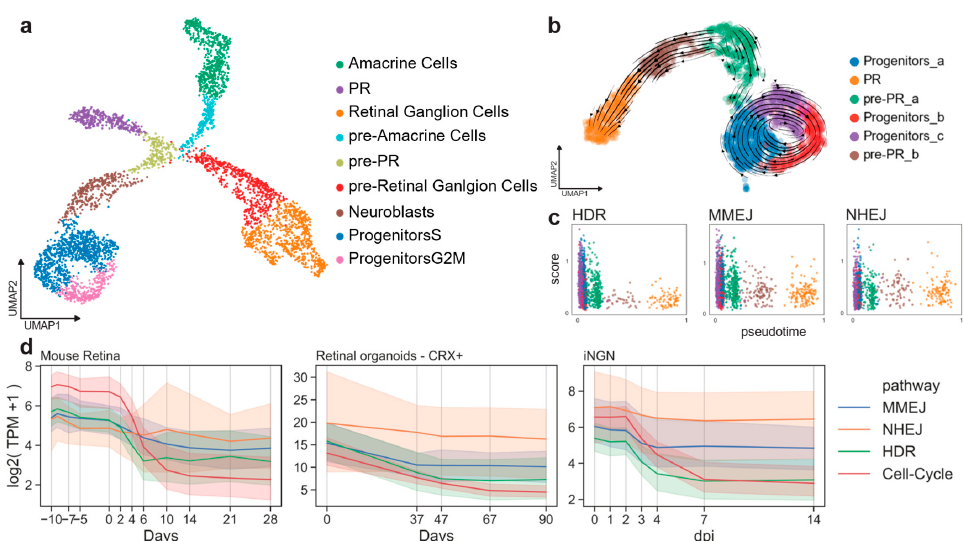
Figure 2. Cell-cycle-related gene expression correlates to DSB pathways. ( a ) E15 mouse retinal cells in two UMAP dimensions showing clusters of known amacrine cells, retinal ganglion cells and PR cells at this developmental stage. ( b) Subset of the developmental PR trajectory in two UMAP dimensions. Arrows represent the vector calculated for each cell according to the RNA velocity approach. ( c ) Pseudo-timed HDR, MMEJ, and NHEJ scores within the photoreceptor developmental trajectory. Cell colors refer to clusters in b). ( d ) DSB repair pathway activity during cell-cycle exit. Lines represent the mean value, and the error bands the 95% confidence